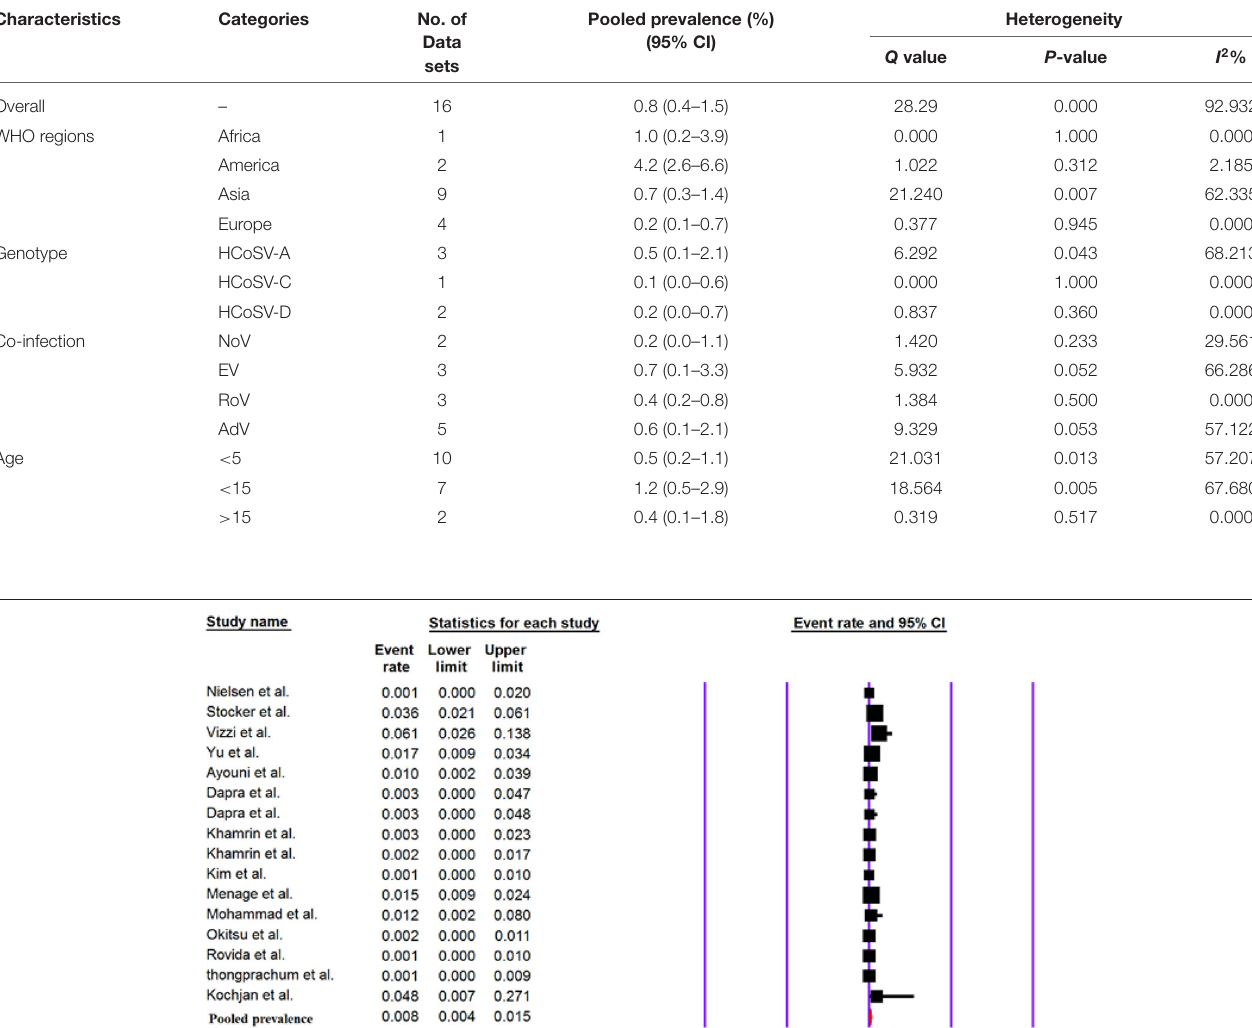
TABLE 6 | The Cosavirus prevalence based on subgroups and studies heterogeneity.